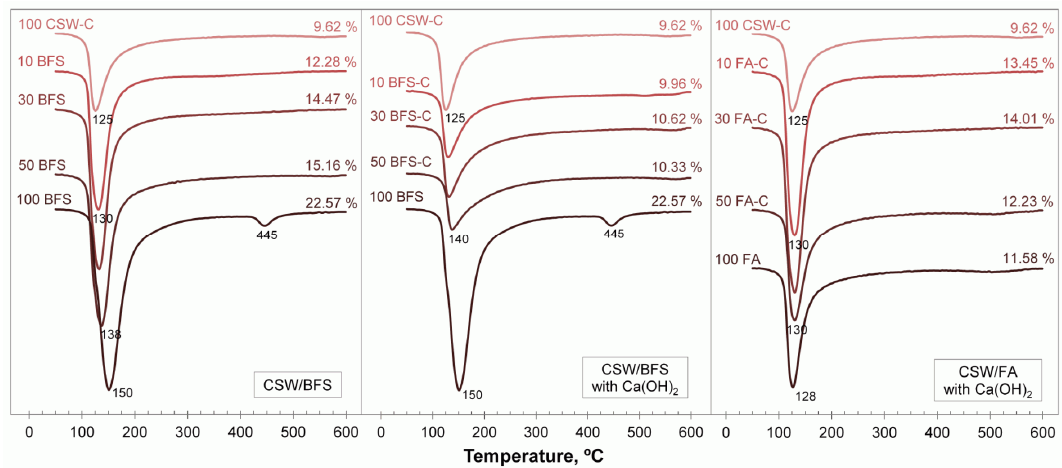
Figure 11. The differential thermogravimetric curves for the alkali-activated CSW blended pastes cured at 65 °C for 7 days. Total mass loss is indicated as a percentage.